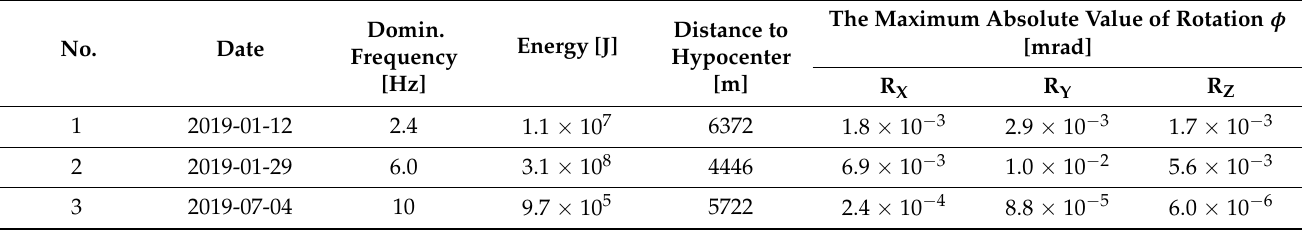
Table 1. Basic data concerning the rotation induced by selected mining tremors recorded at the seismic station located at Zelazny Most Tailing Pond.